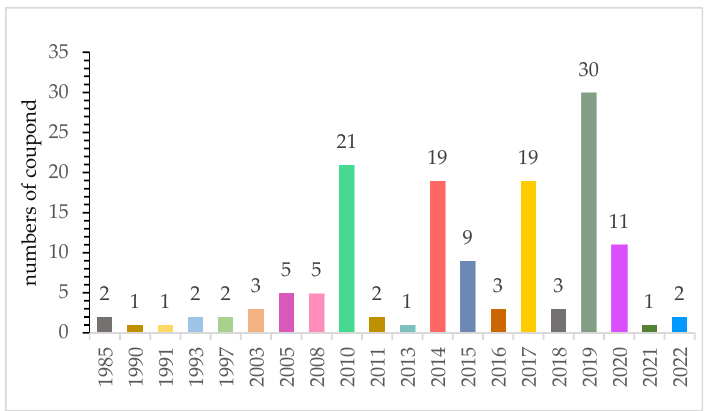
Figure 6. Annual numbers of sulfur-containing compounds identified from 1985 to 2022. (Keywords: sulfur-containing compound, plant endophytic fungi; Databases: SciFinder, PubMed).